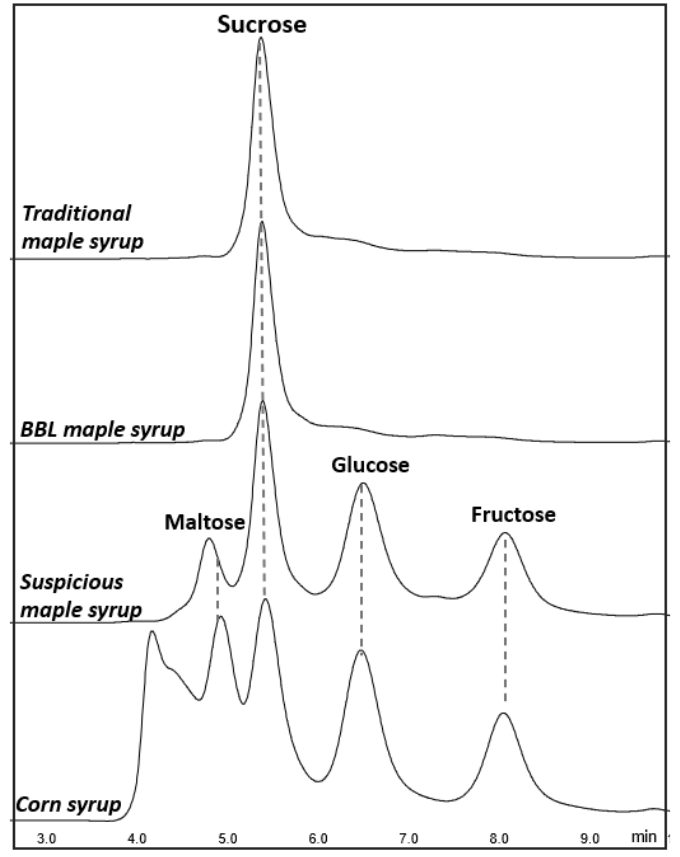
Figure 1. Representative HPLC ‐ RID chromatograms of sugar profiles for traditional maple syrup, BBL maple syrup, suspicious maple syrup and corn syrup.